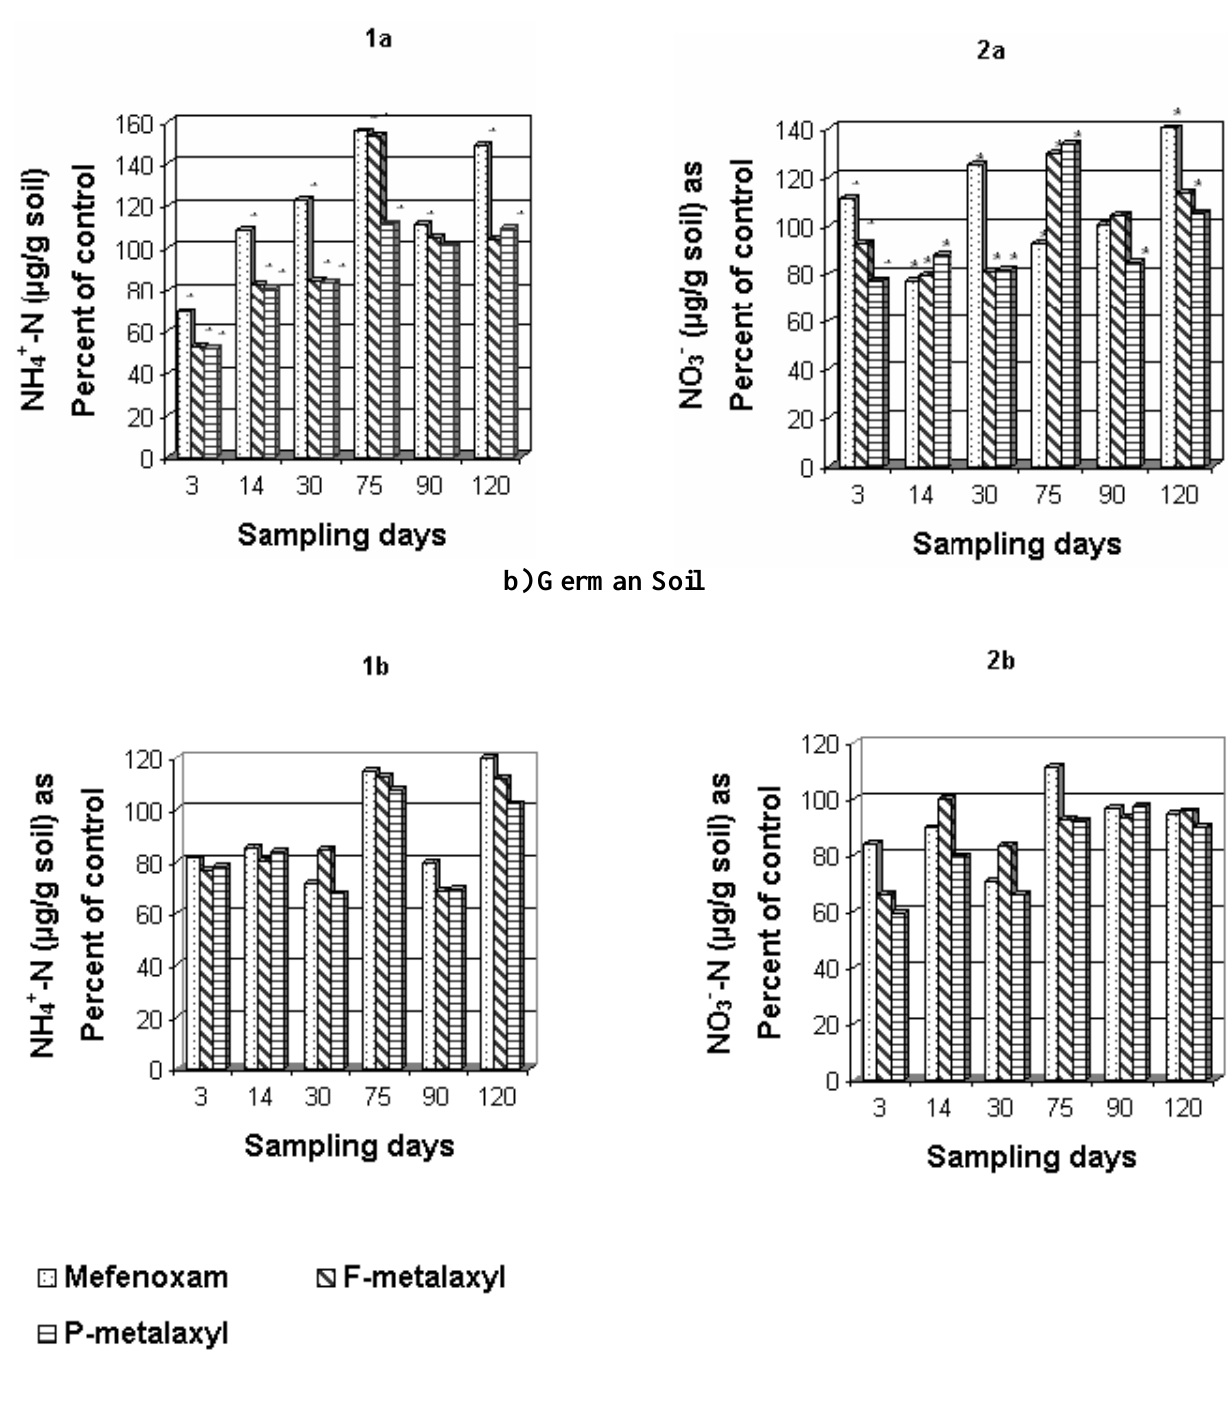
Figure 6: Effect of fungicides on the availability of NH 4+ -N and NO 3- -N in the Cameroonian (a) and German (b) soils. * P<0.05 between fungicide addition and no fungicide addition (paired Student